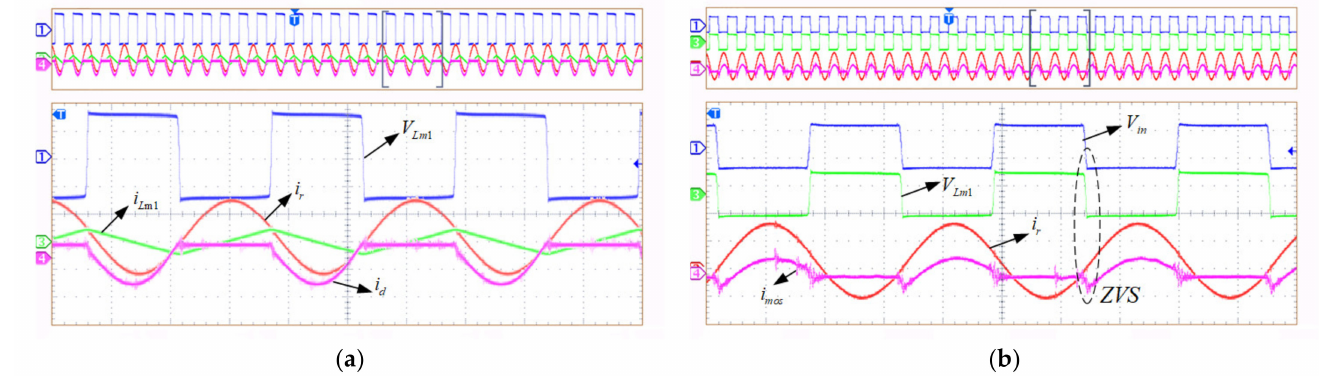
Figure 16. Experimental waveforms at switching frequency equal to the resonant frequency, and ( a , b ) show the corresponding current of the diode and low-voltage side MOS tube, respectively.